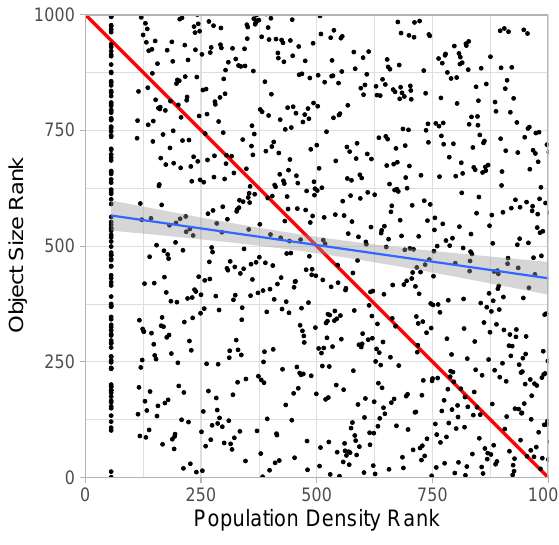
Figure 4. Interaction between the population density and the object size. The diagonal red line represents our idealised second hypotheses, the blue line is a linear regression estimate.